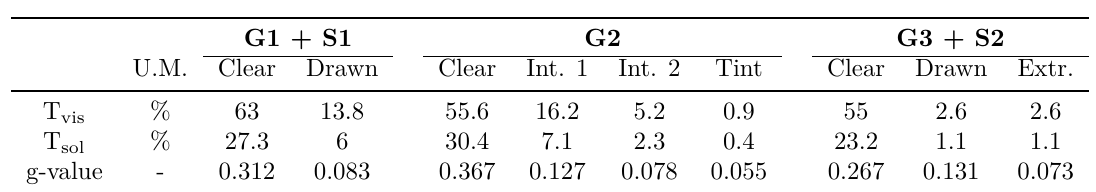
Table 3. Optical and thermal properties of the three window systems.